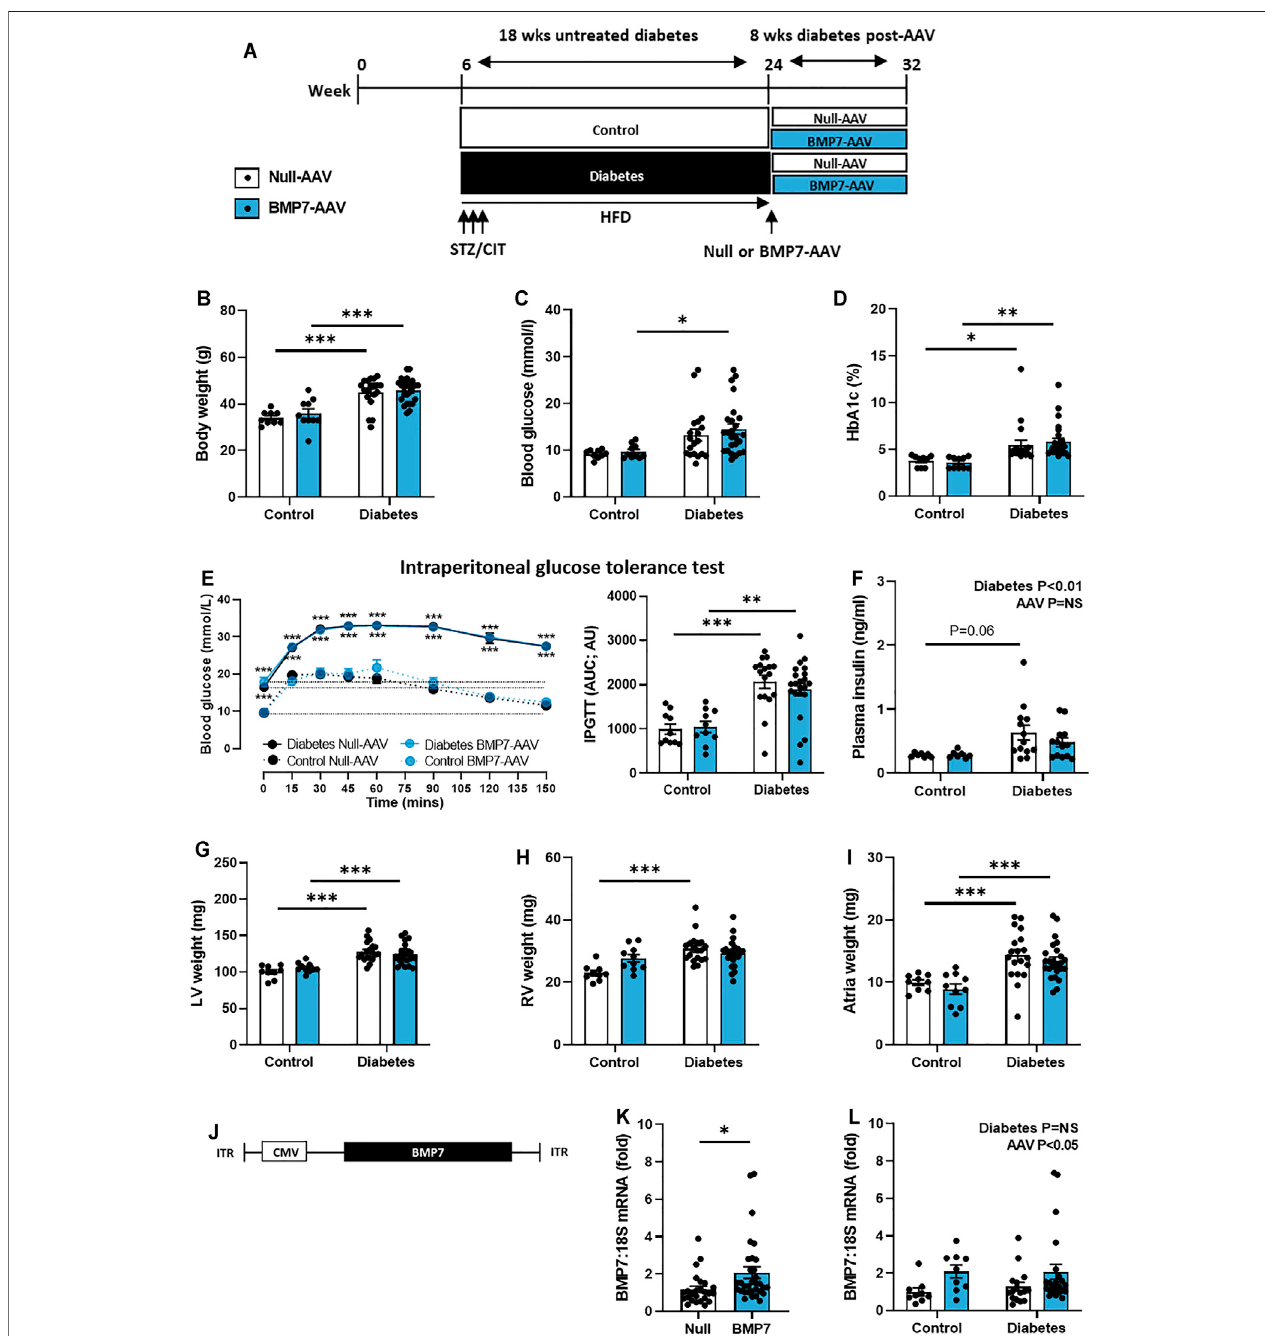
FIGURE 1 | The effect of rAAV6-BMP7 gene therapy on diabetes-induced systemic and morphological changes. (A) Overview of experimental protocol, (B) body weight, (C) bloodglucose, (D) glycatedhaemoglobin(HbA1c), (E) intraperitonealglucosetolerancetest(IPGTT;timecourseandAUC) ,(F) plasmainsulin, (G) LVweight, (H) RVweight, (I) atriaweight. (J) SchematicrepresentationoftheAAVvectorusedtoachievecardiac-selectiveoverexpressionofBMP7,containingtheCMVpromotor, the BMP7 gene and inverted terminal repeats (ITRs). (K) Cardiac mRNA expression of BMP7 in rAAV6-Nulland rAAV6-BMP7 groups (data pooled for Control and Diabetes)and (L) infourtreatmentgroups.Dataarepresentedasmean ± SEM. n (cid:1) 7 – 25pergroup(seeindividualdatapoints).* p < 0.05,** p < 0.01,*** p < 0.001. (B – D, F – I, L) Two-way ANOVA followed by Tukey ’ s post hoc test, (E) repeated measures two-way ANOVA followed by Tukey ’ s post hoc test, or (K) unpaired t -test. AAV, adeno-associatedvirus;AUC,area-under-the-curve; BMP7,bonemorphogeneticprotein 7;CIT,sodium citrate; CMV,cytomegalovirusvirus;LV, leftventricle;RV,right ventricle.